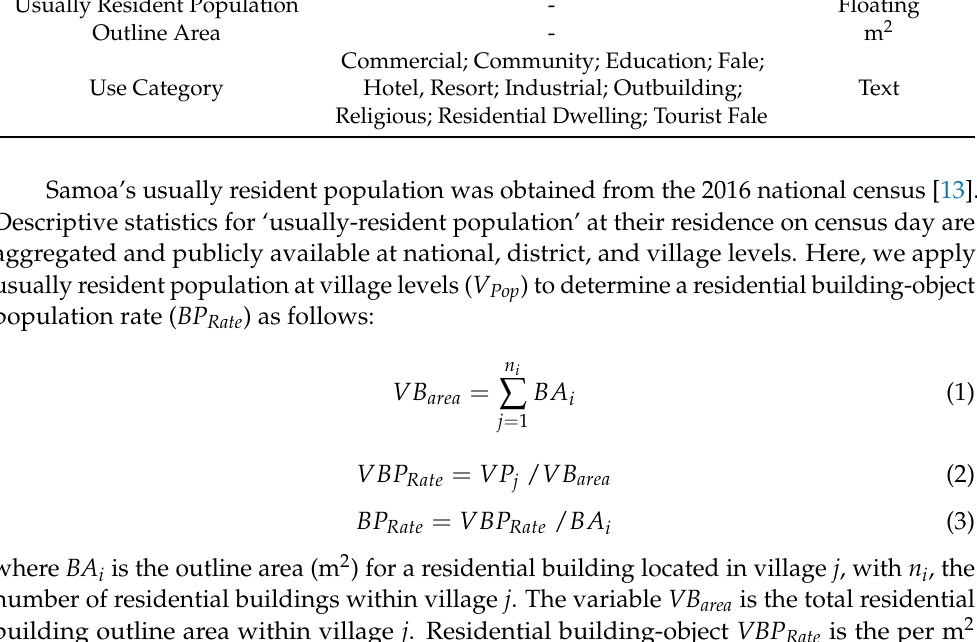
Table 1. Summary of attributes represented in the building exposure data. Primary Attribute Secondary Attribute Metric or Value Construction Frame Masonry, Steel, Reinforced Concrete, Timber Text Usually Resident Population - Floating Outline Area - m 2 Commercial; Community; Education; Fale; Use Category Hotel, Resort; Industrial; Outbuilding; Religious; Residential Dwelling; Tourist Fale